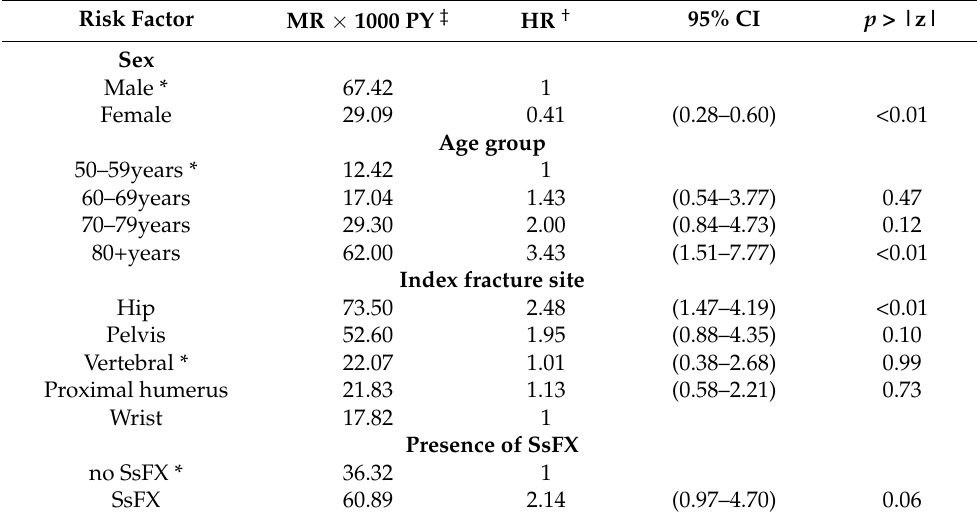
Table 4. Mortality hazard ratio associated to sex, age, type of index fracture, and presence of subsequent fracture